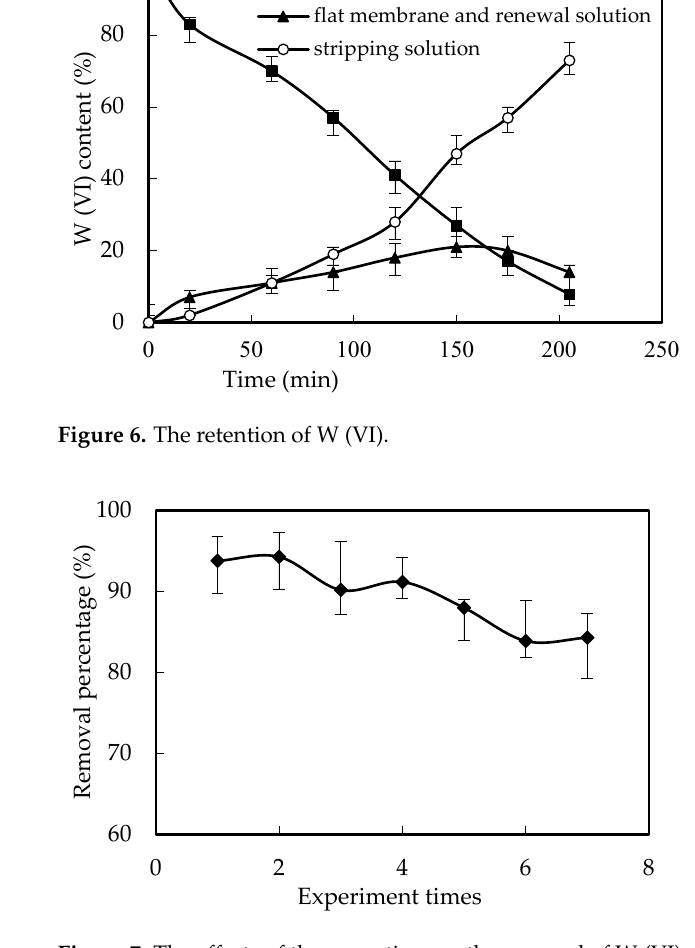
Figure 7. The effects of the reuse time on the removal of W (VI).